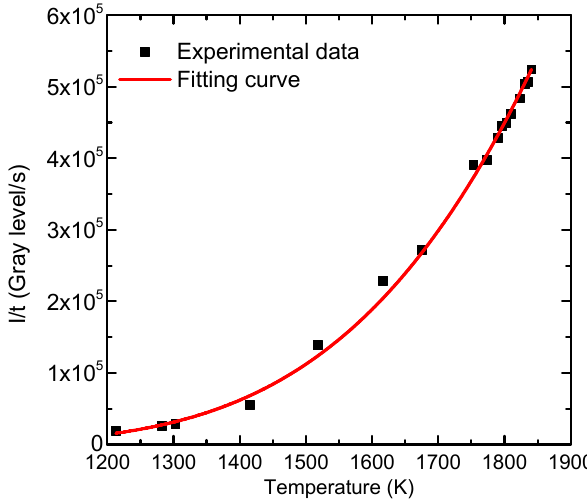
Figure 4. A typical temperature calibration curve of I/t i (pixel intensity normalized by the integration time) versus temperature.